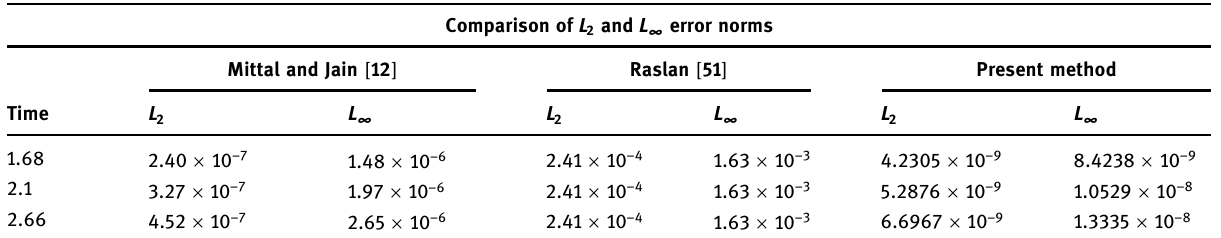
Table 7: Compatibility of errors with [ 12 ] and [ 51 ]